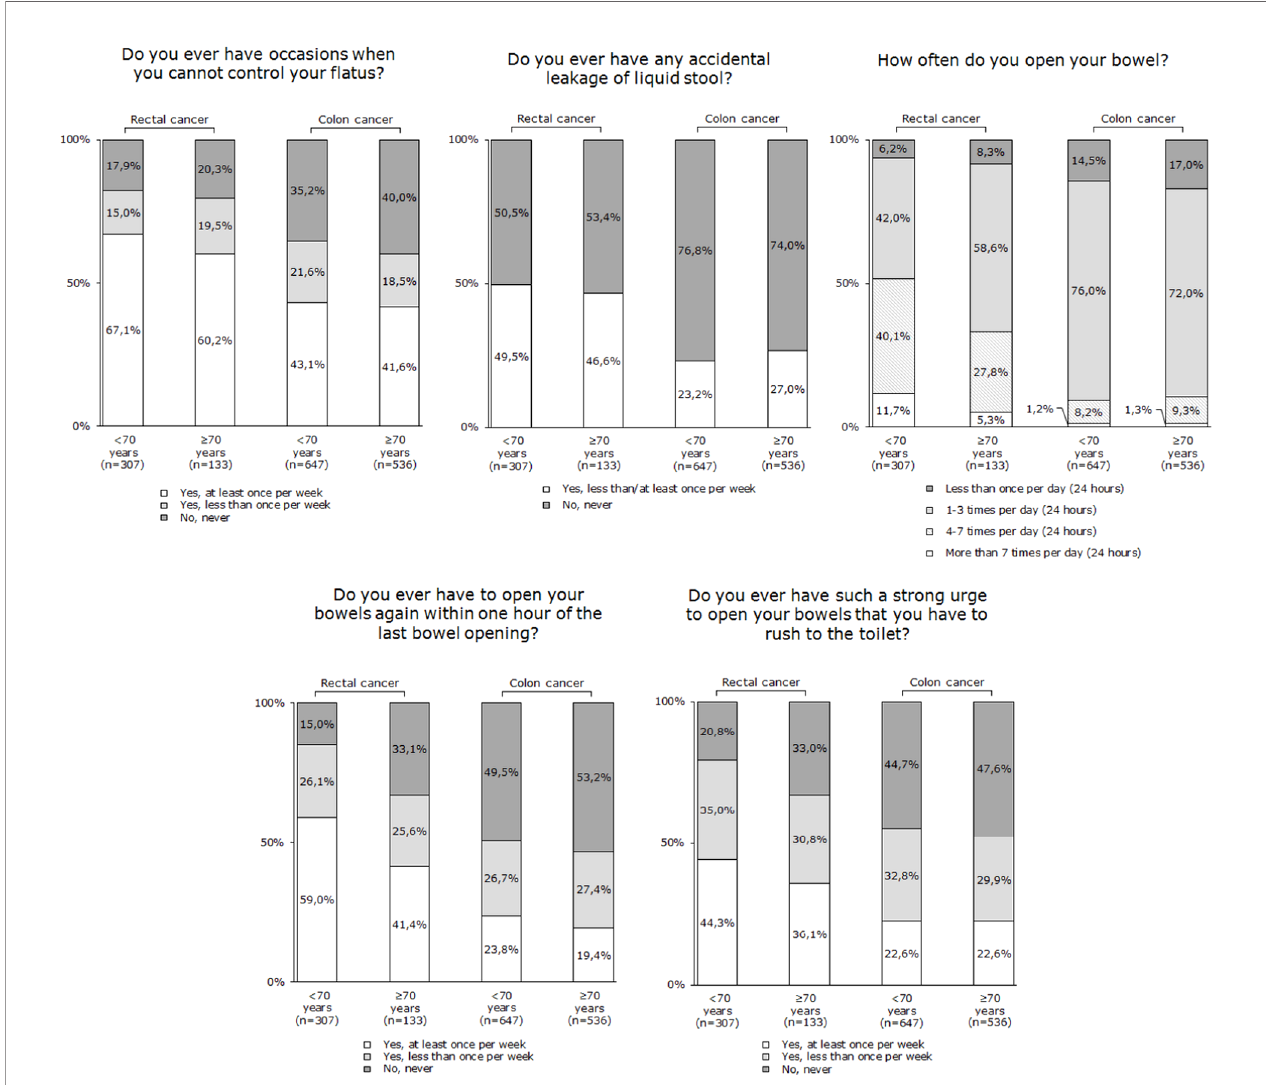
FIGURE 2 | LARS subscale items, separately for rectal and colon cancer patients, strati fi ed by age groups (<70 years and ≥ 70